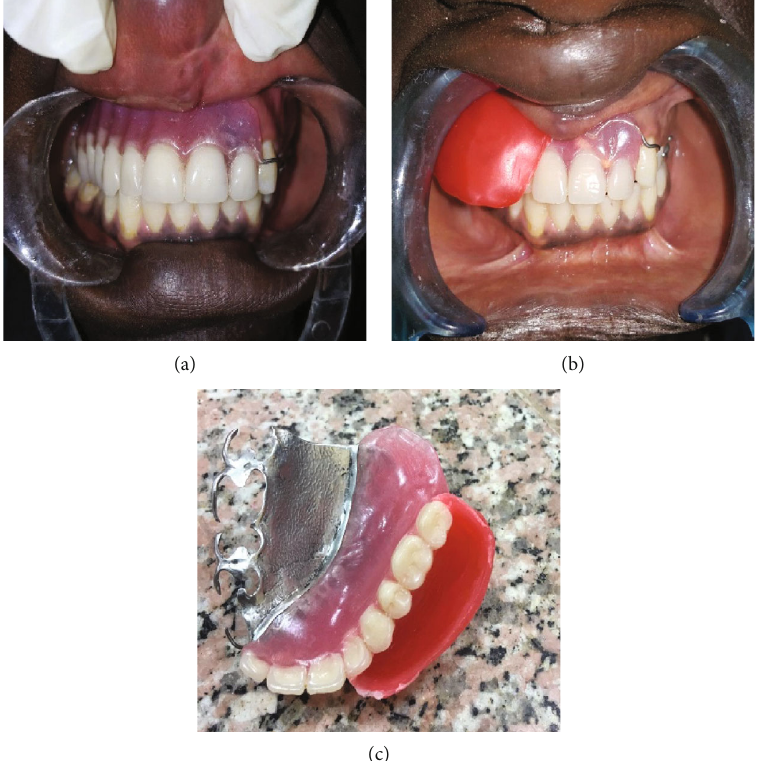
Figure 2: (a) De fi nitive obturator in maximum intercuspal position; (b) intraoral wax try-in of the plumper; (c) plumper impression